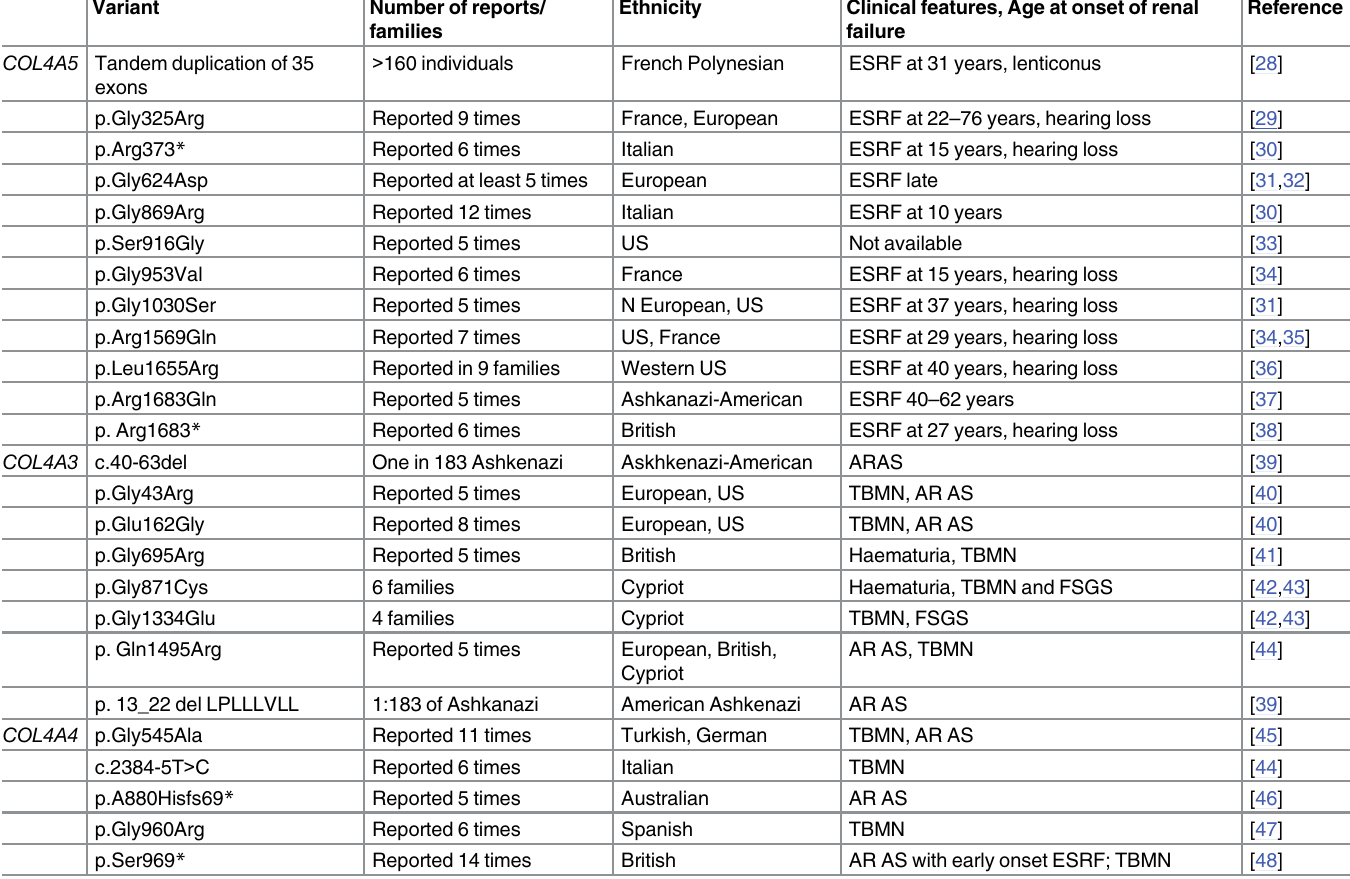
Table 4. Common Founder mutations in the COL4A5 , COL4A3 and COL4A4